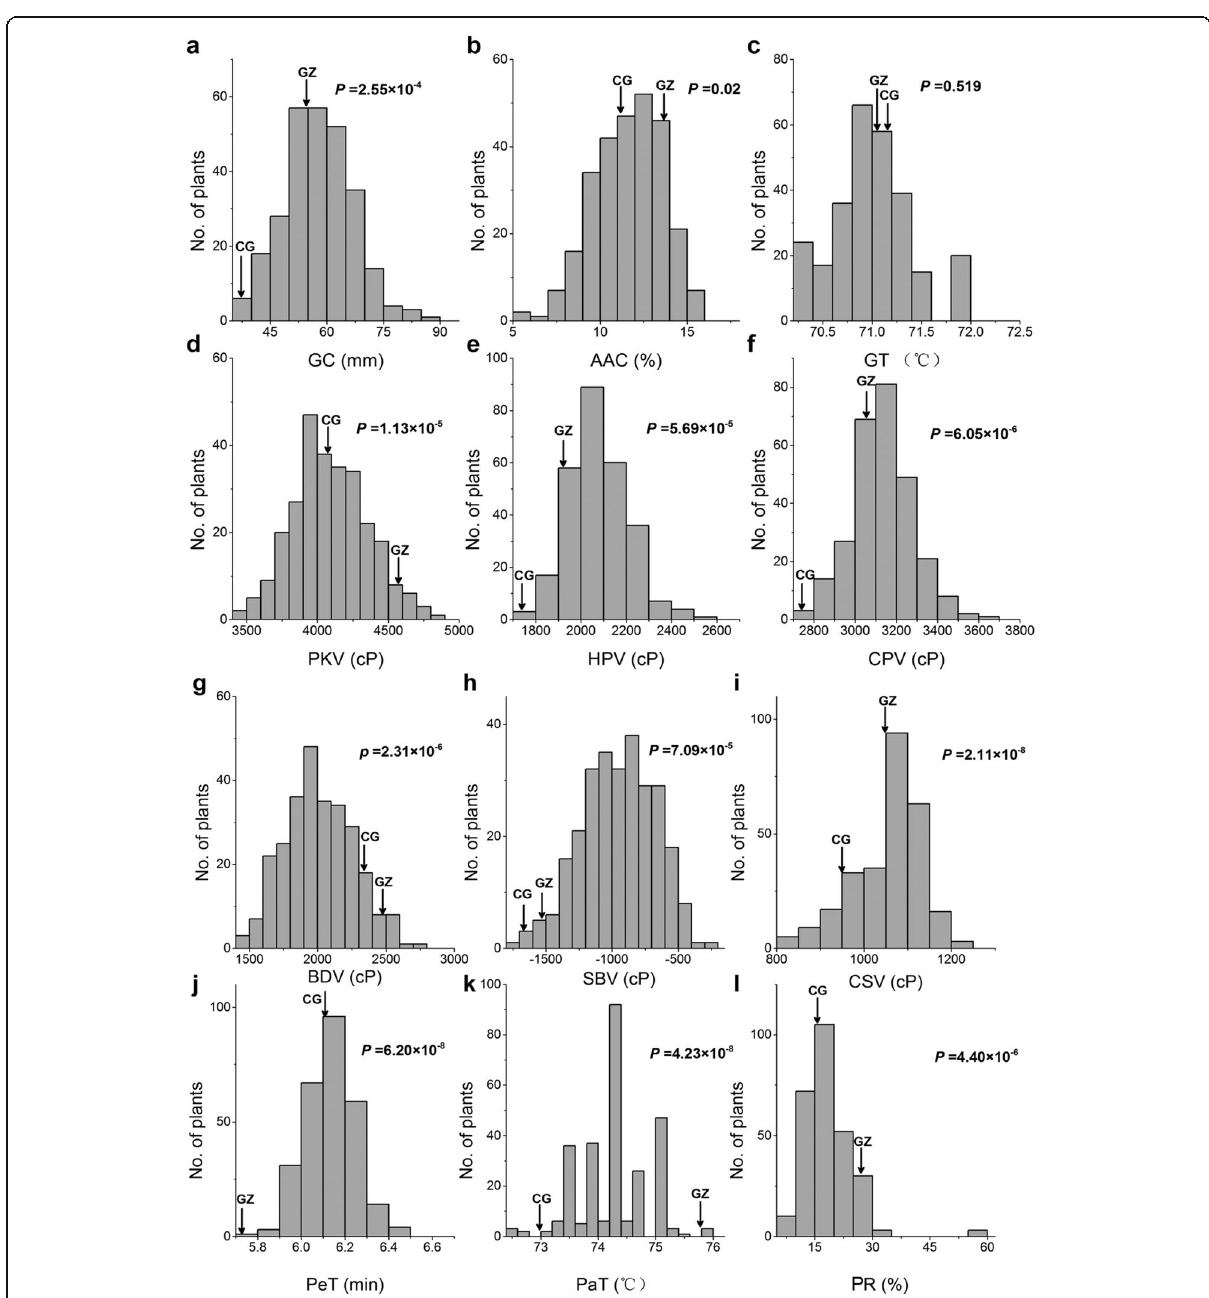
Fig. 2 Distribution of the quality characters in BILs from BC 1 F 12 . GZ, GZ63S; CG, CG173R; a Gel consistency (GC); b Apparent amylose content (AAC); c Gelatinization temperature (GT); d Peak viscosity (PKV); e Hot paste viscosity (HPV); f Cool paste viscosity (CPV); g Breakdown viscosity (BDV); h Setback viscosity (SBV); i Consistence viscosity (CSV); j Peak time (PeT); k Pasting temperature (PaT); l Percent of retrogradation (PR). The P values, generated by student ’ s tests, denote the differences between GZ63S and